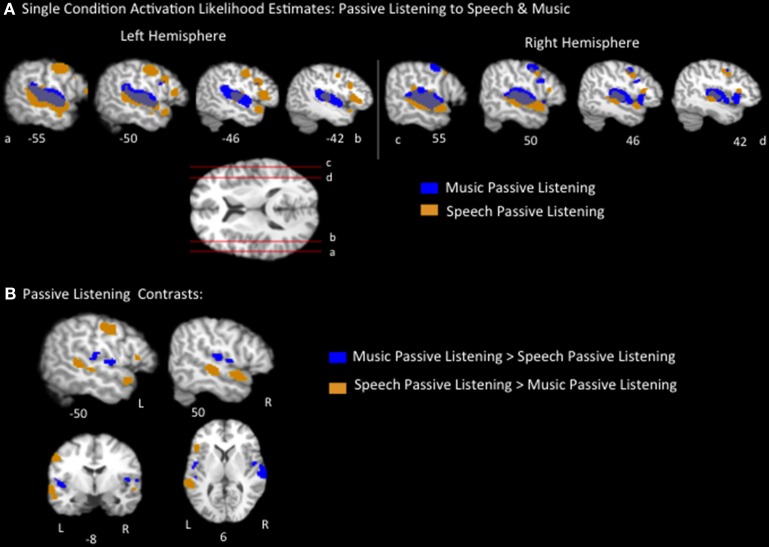
(A) Representative sagittal slices of the ALE for passive listening to speech, p < 0.05, corrected, overlaid on top of the passive music listening ALE. (B) Speech vs. music passive listening contrasts results, p < 0.05 corrected.